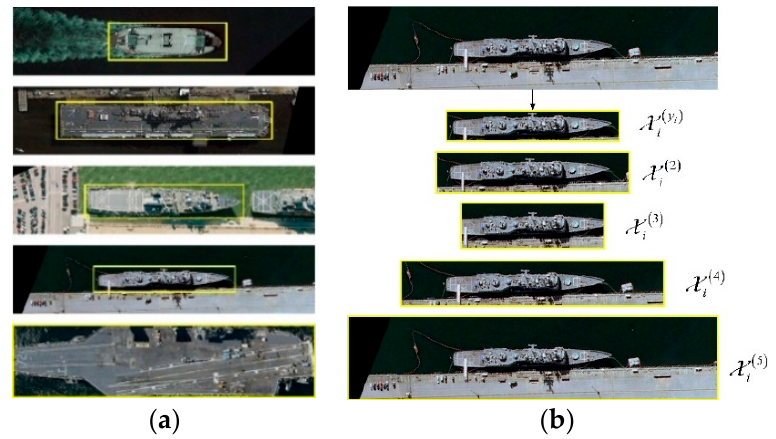
Figure 4. Illustration of slices with proper sizes and multiscale slices. ( a ) Proper sizes of slices for different objects ( b ) illustration of multiscale slice.